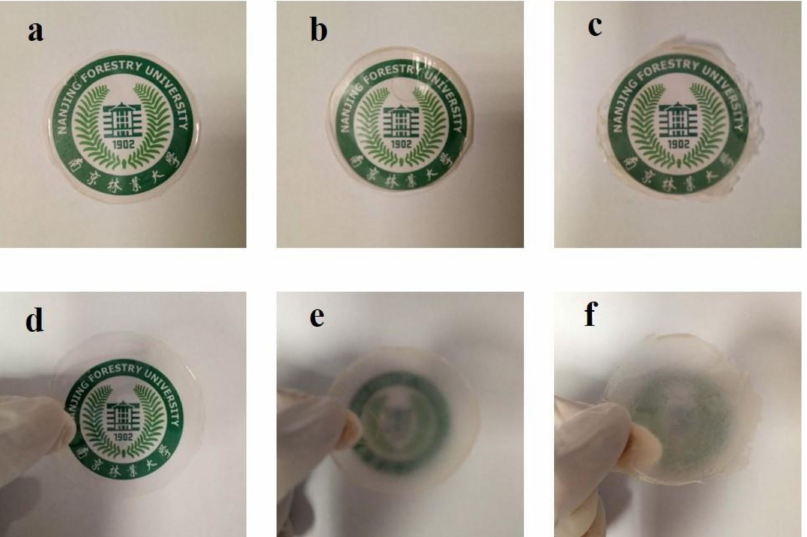
Figure 1. ( a – c ) Visual appearance of 2,2,6,6-tetramethylpiperidine-1-oxyl (TEMPO)-oxidized cellulose nanofibril (TOCN) films, TOCNs/ TEMPO-oxidized wood fibers B (TOWFs-B), and TOCNs/TOWFs-C films in close contact with underneath color pattern. ( d – f ) Digital photographs of TOCN films, TOCNs/TOWFs-B films, and TOCNs/TOWFs-C films were lifted up to 6 cm above color pattern.